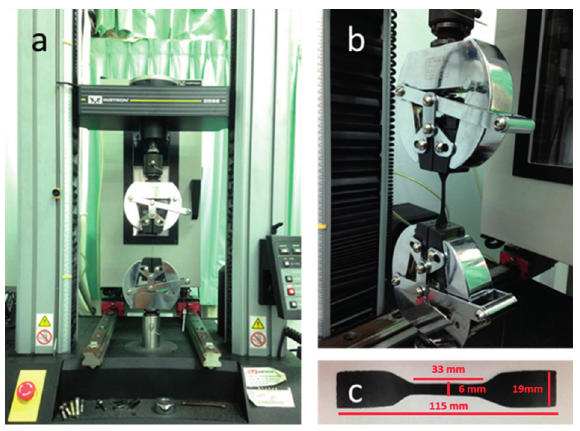
Figure 2. ( a ) The tester, ( b ) the grips, and ( c ) the samples of tensile